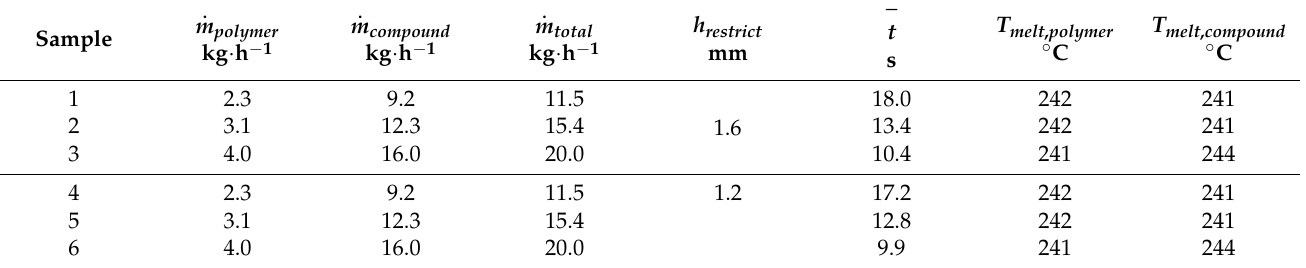
Table 8. Processing conditions: individual throughputs, overall throughputs, channel height in the restricted flow area, mean residence time within the die for co-extrusion, melt temperature of the polymer T melt , polymer , and melt temperature of the compound T melt , compound of samples 1 to 6 out of polymer and compound.